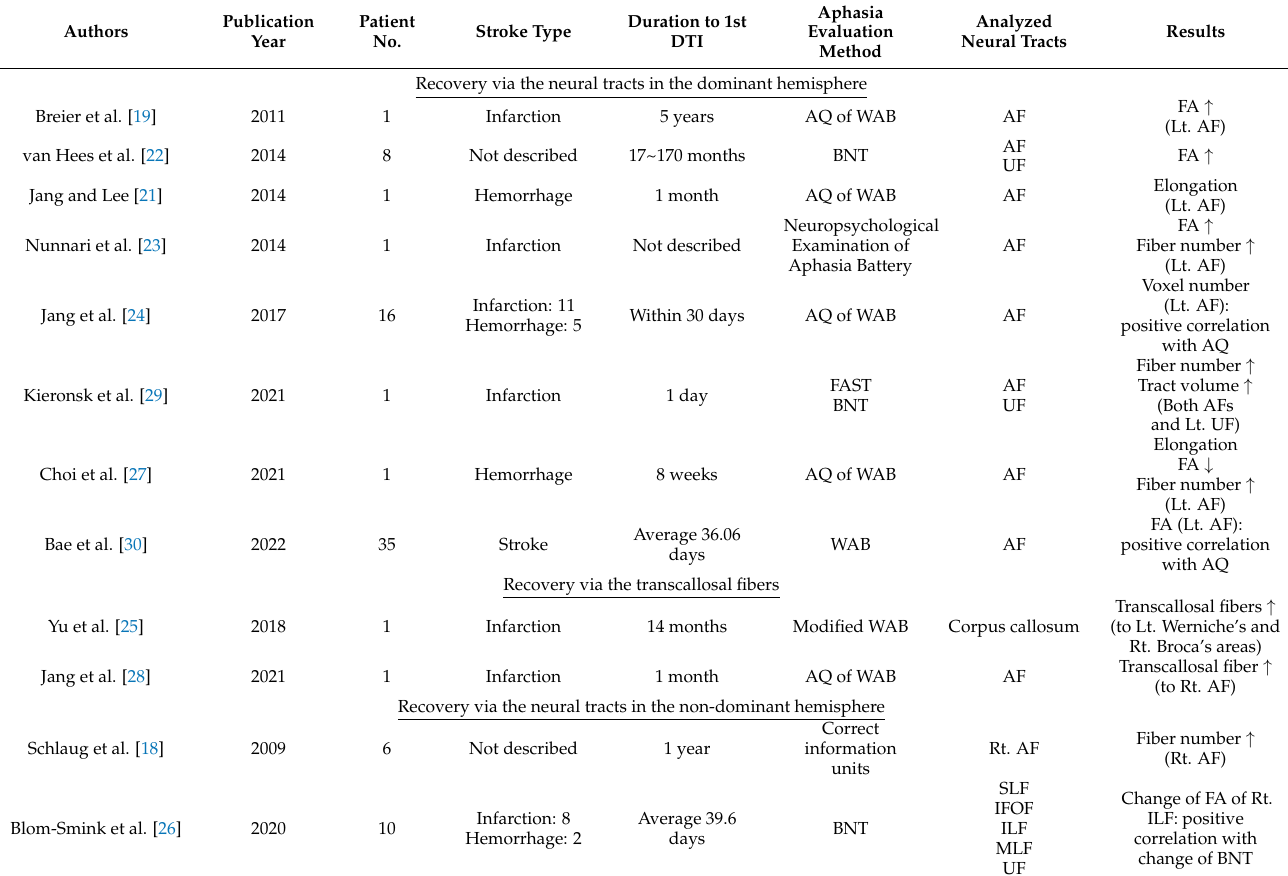
Table 2. Diffusion tensor tractography studies on the mechanisms of aphasia recovery in